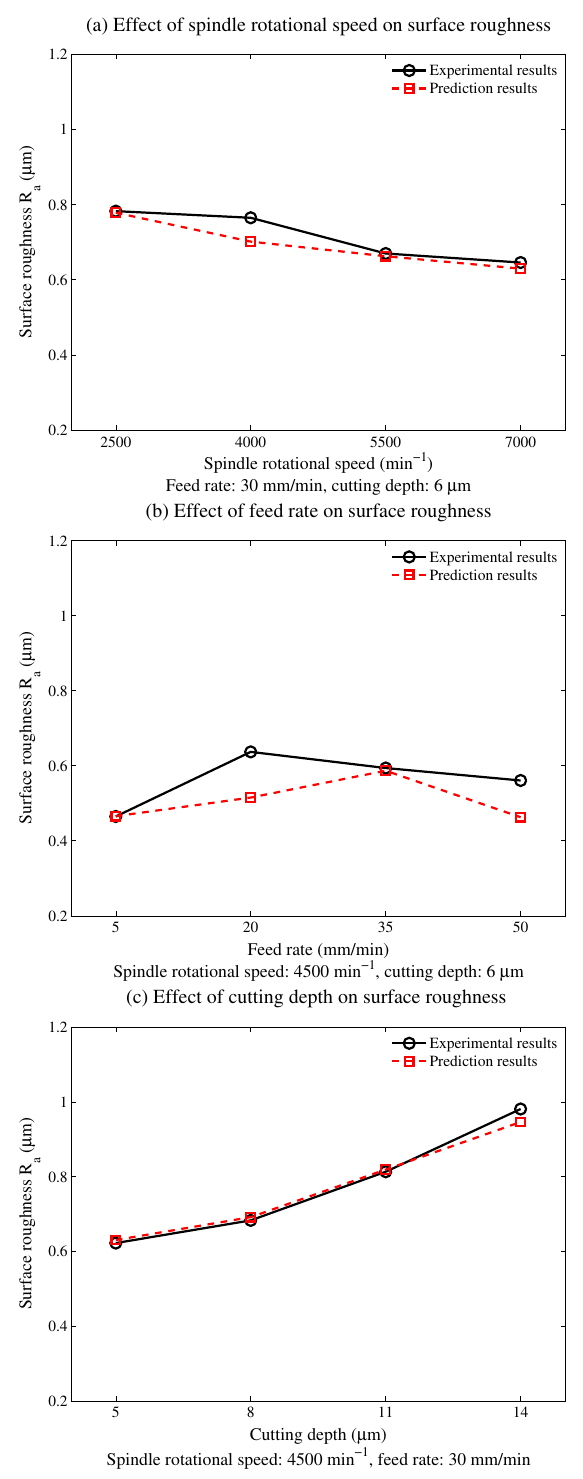
Figure 13. Effects of the input variables on the surface